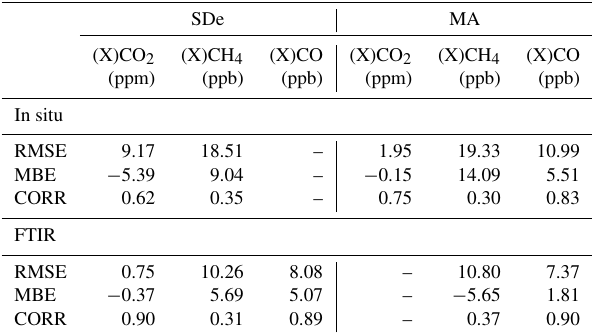
Table 3. Overview of the WRF-GHG performance for hourly in situ and column observations of GHG at Réunion Island. The compari- son with the column observations is based on the smoothed model profiles. There are no in situ CO data available at SDe (Saint-Denis) and no XCO 2 data at MA